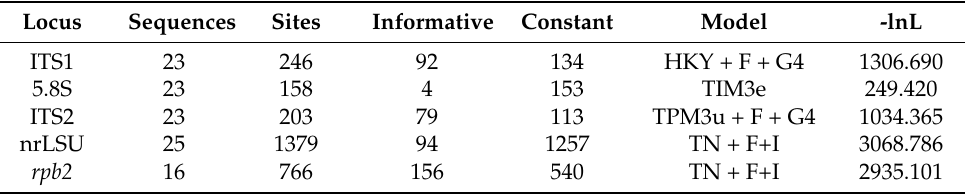
Table 2. Overview of number of characters (total, informative, constant) and selected model of nucleotide substitution, by